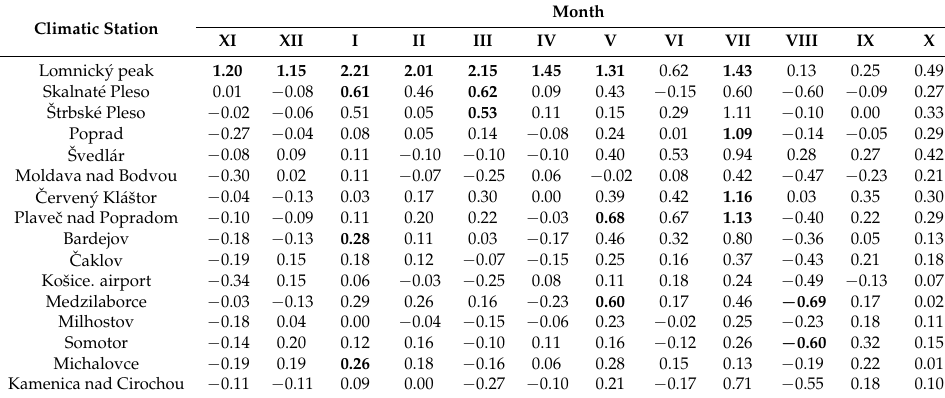
Table 3. Monthly precipitation trends in climatic